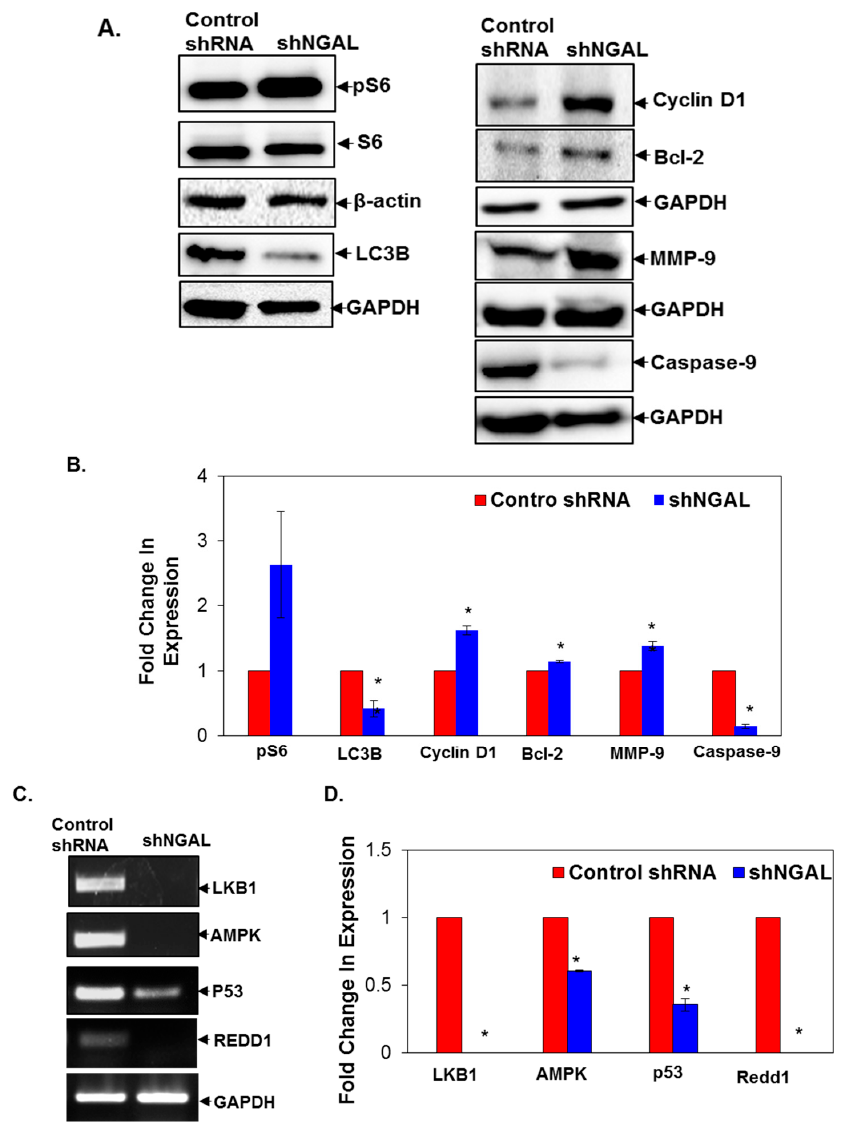
Figure 5. Silencing of NGAL activated mTOR signalling and induced autophagy. ( A ) Expression of proteins involved in mTOR signalling and autophagy. ( B ) Fold change in expression of proteins as analyzed by image lab software ( n = 2). ( C ) mRNA expression of LKB1-AMPK-P53-Redd1 in NGAL knockdown cells. ( D ) Fold change in mRNA expression as analyzed by image lab software ( n = 3). Data are means ± SE. * = p < 0.05.